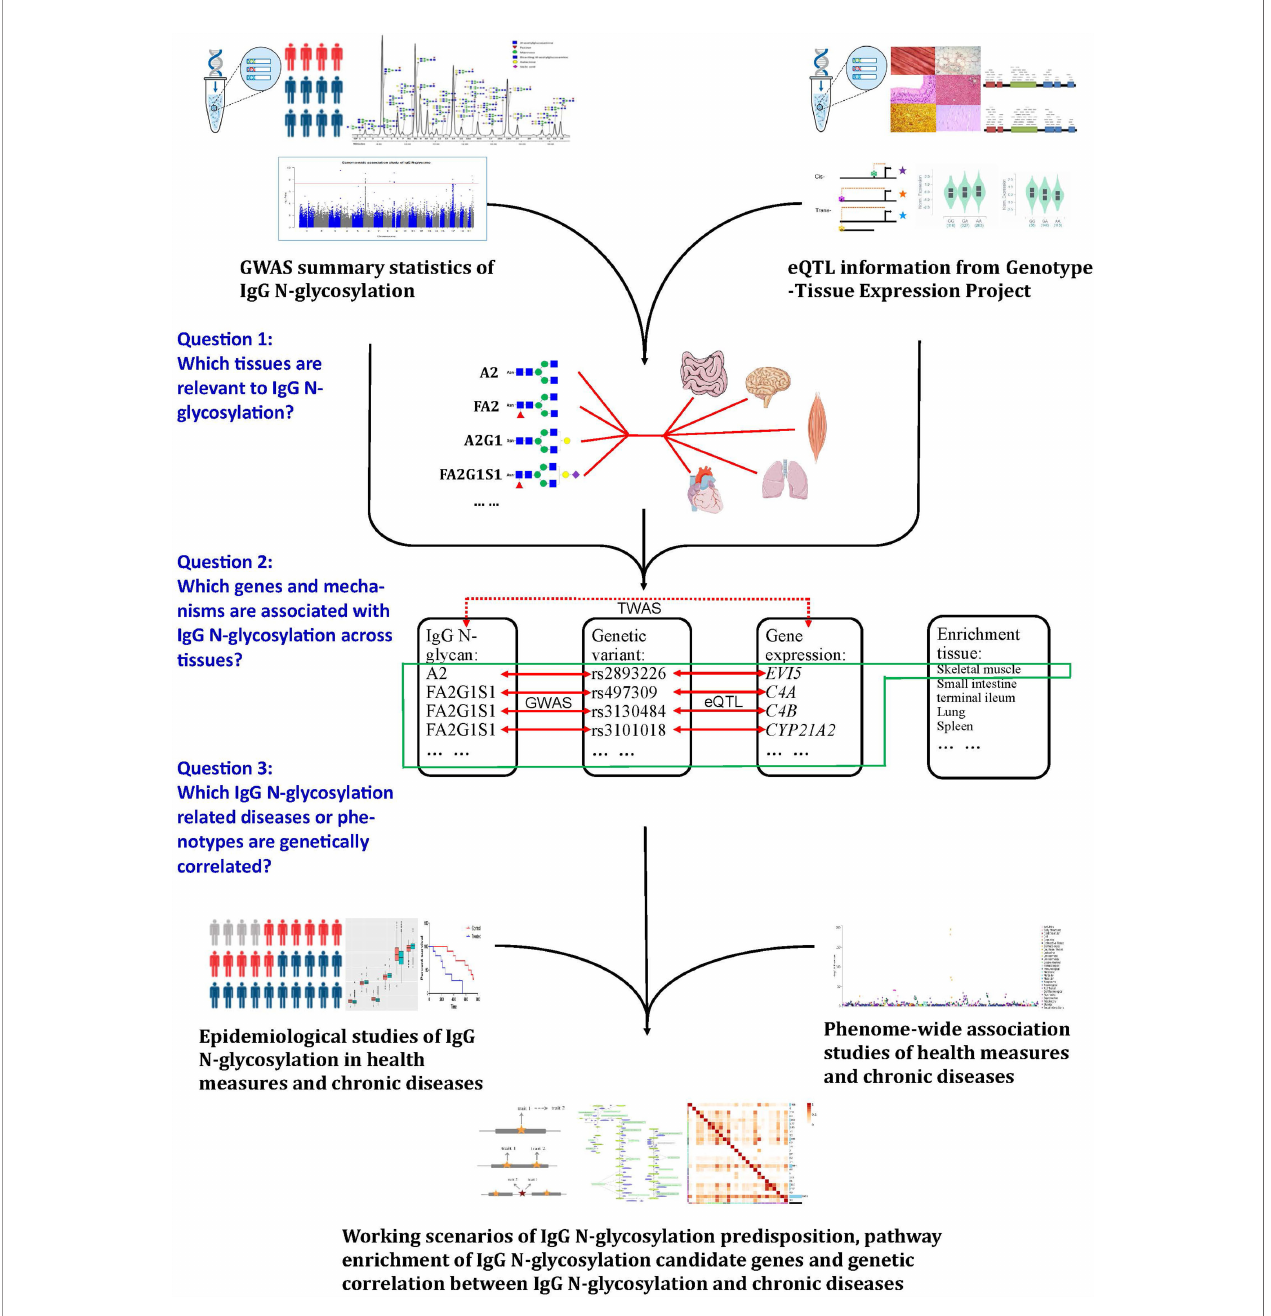
FIGURE 1 | A schematic analysis plan in the study. Leveraging IgG N-glycosylation genome-wide association studies (GWAS), summary statistics, and gene expression datasets: (1) to fi ltrate the tissues enriched in IgG N-glycosylation signal, (2) to identify the genes most signi fi cantly associated with IgG N-glycosylation features, and (3) to investigate the diseases or phenotypes involved with IgG